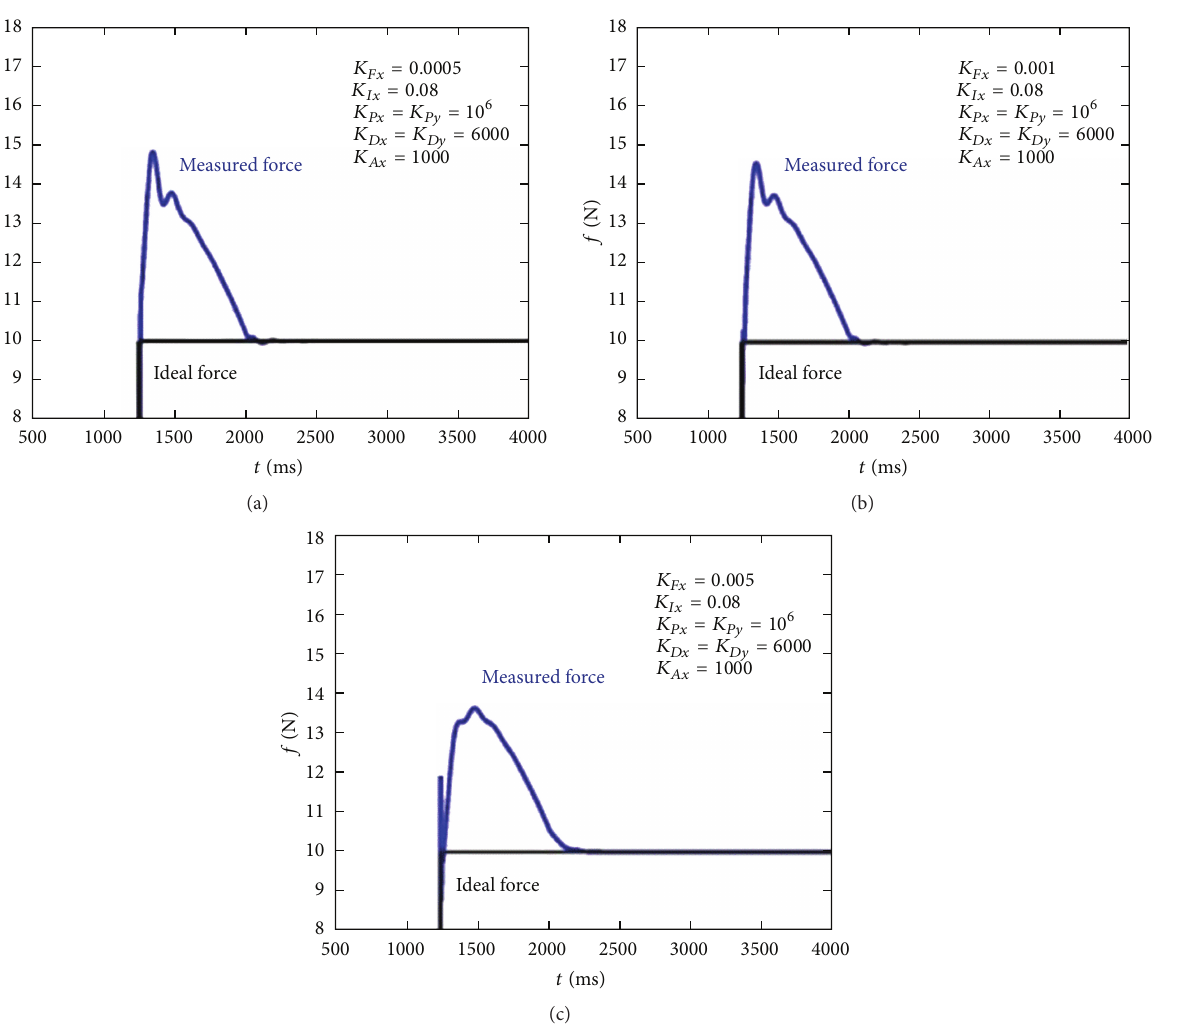
Figure 20: End-Effector force value (N) varying the 𝐾 𝐹 gain in the PI system: (a) 𝐾 𝐹 = 0.0005 ; (b) 𝐾 𝐹 = 0.001 ; (c) 𝐾 𝐹 = 0.005 .